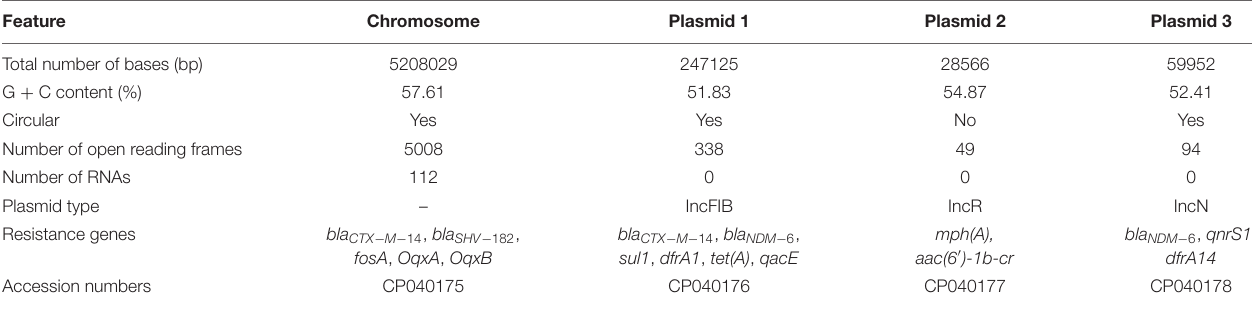
TABLE 2 | Genomic features of